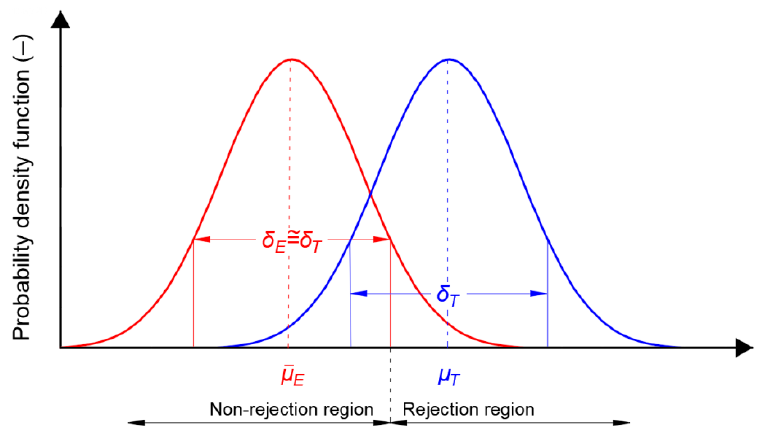
Figure 5. Relationship between the empirical (red) and the actual (blue) probability density function of measurement errors, together with the rejection and non-rejection regions of the distribution fit hypothesis.